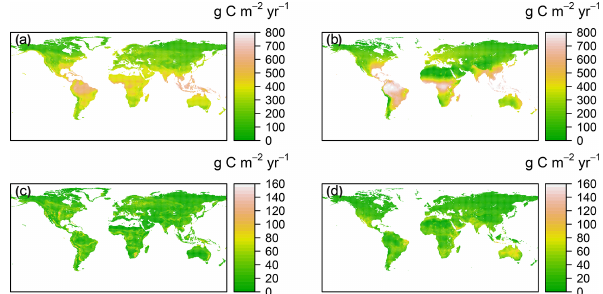
Figure 2. Spatial patterns of annual mean and standard deviation for RF-RA (a, c) and Hashimoto2015-RA (b, d) from 1980 to 2012. The standard deviation was applied to characterize the inter-annual variability following Yao et al. (2018).